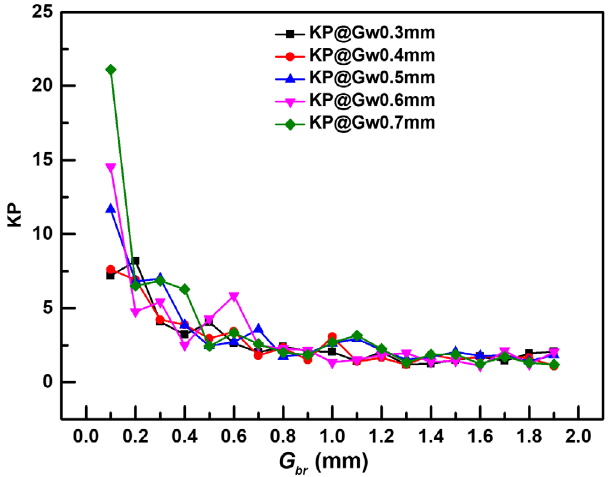
FIG. 18. Influence of G w and radius of blend edge G surface electric field.